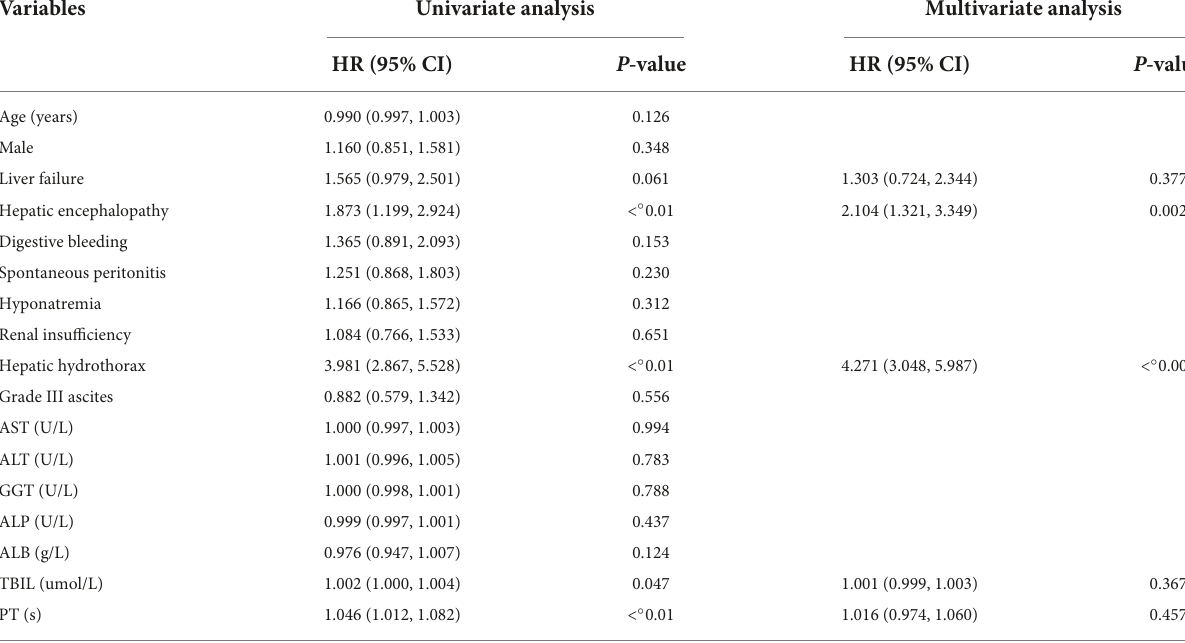
TABLE 2 Univariate and multivariate Cox proportional hazards model in the entire matched cohort ( n = 212 patients).